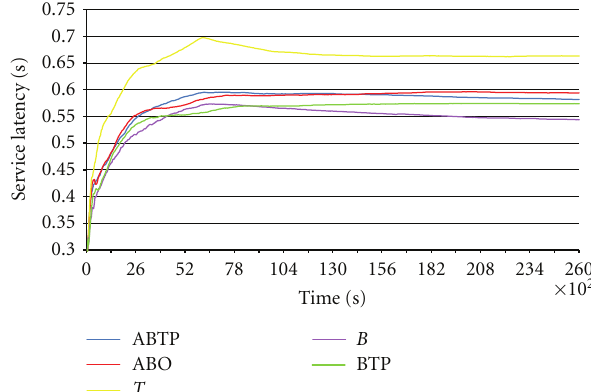
Figure 13: Average packet loss rates on di ff erent MA quantity and optimization criteria.